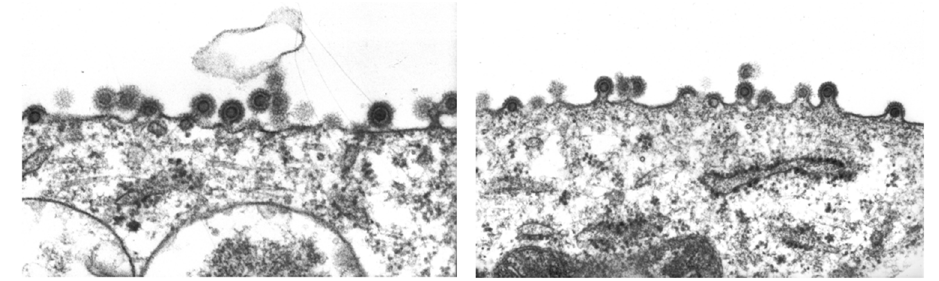
Figure 2. Transmission electron microcopy of BFV ‐ Riems budding at the membrane of infected KTR cells. BFV ‐ infected KTR cells were analyzed in transmission electron microscopy as described previously [38] (performed by Birgit Hub). Two sites of particle assembly from a single BFV ‐ infected cell are shown.